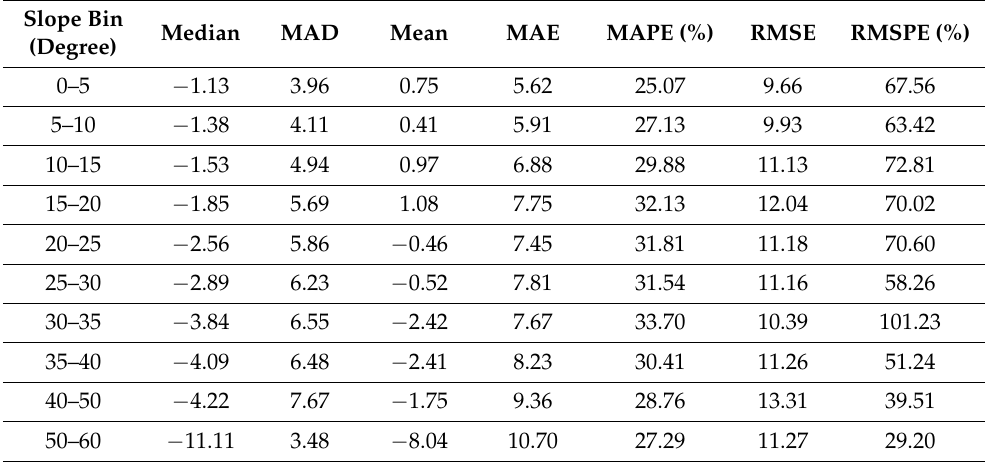
Table 5. Accuracy of GEDI canopy height estimates of individual footprints (11,832) for different slope bins (ALS 95 , GEDI 95